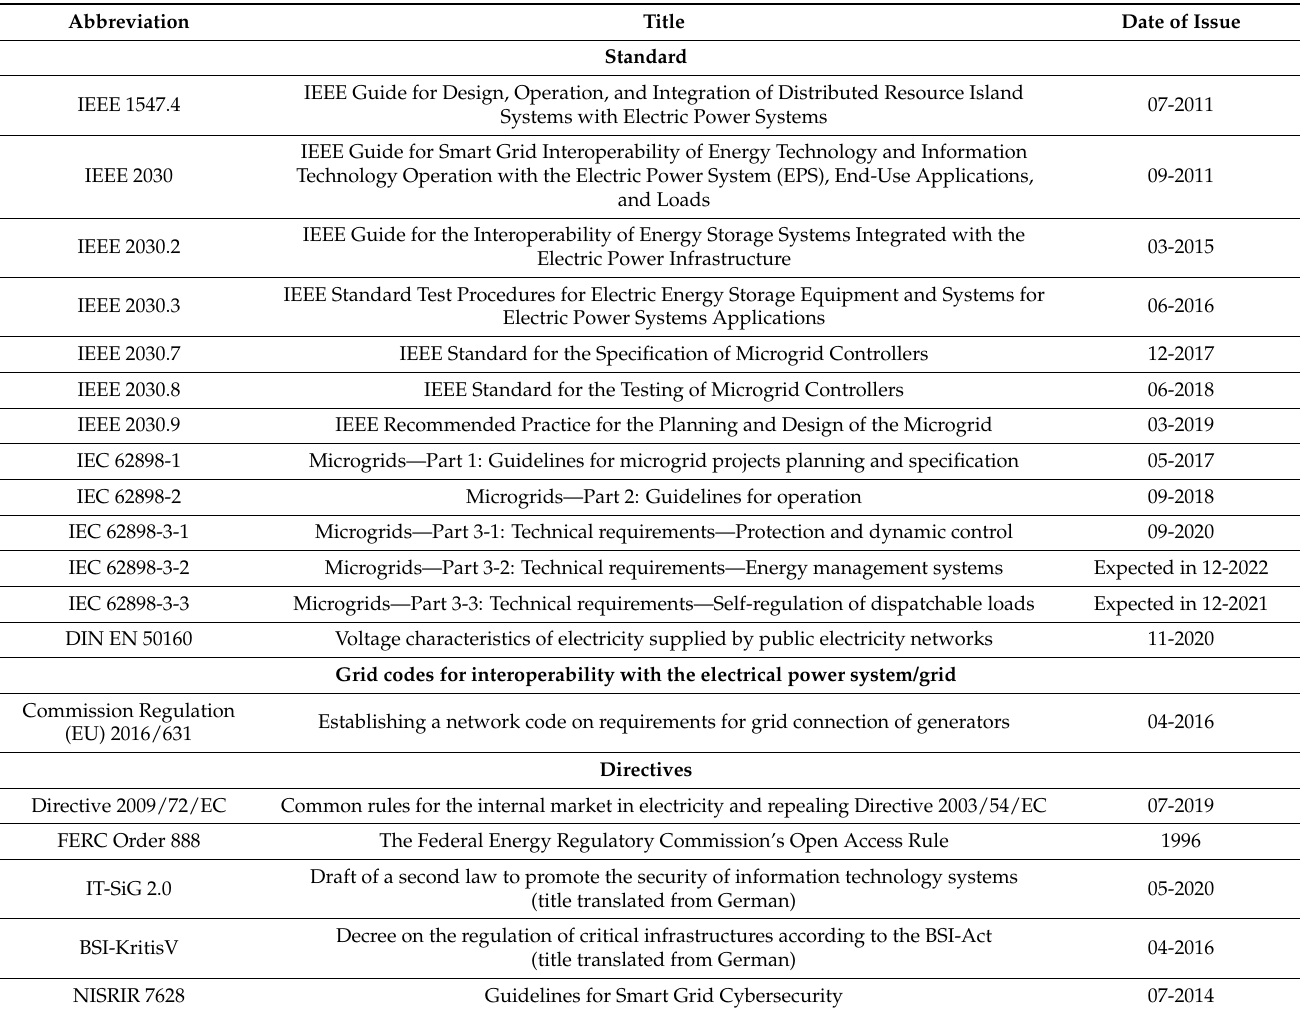
Table 1. Standards, grid codes and directives for delta-wye transformer (MG)